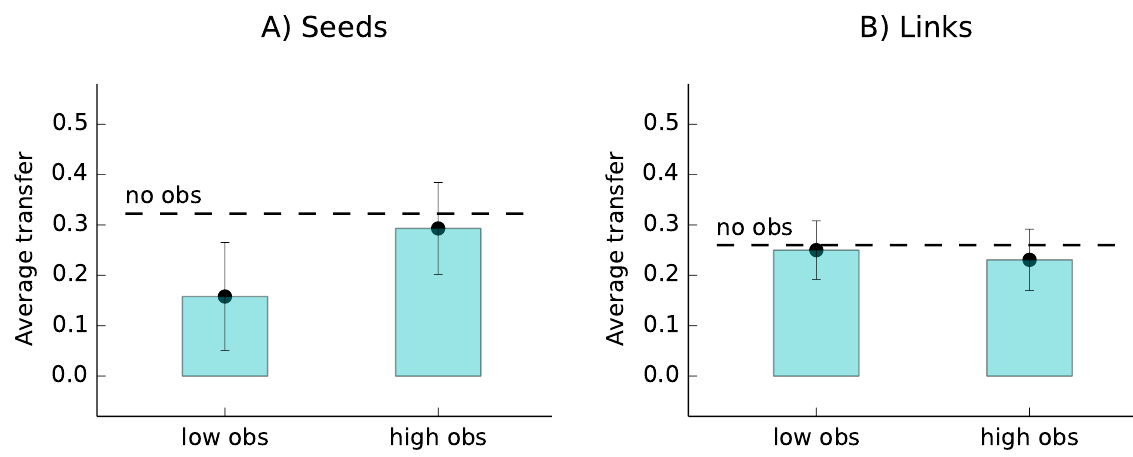
Figure 2: The effect of third-party influence on the amount transferred from the next participant. The figure shows the mean transfer rate and 95% confidence interval for A) seeds and B) links with no loss. Compared to seeds in the no-observation treatment condition, seeds who observed low transfer levels had a significantly lower transfer rate but seeds who observed high transfer levels did not have higher transfer rates. This effect of observing the behavior of others is not evident among